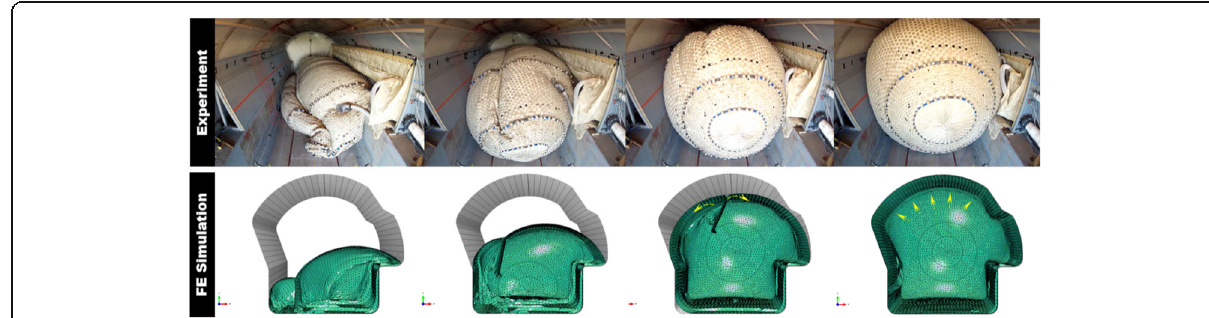
Fig. 16 Phase 2b-ET, full-scale testing, and three-layer Vectran plug. Initial inflation and holding of membrane material by passive restrainers (top). For additional details see [[69]92 – 94]. Cross-section of finite element simulation of initial inflation and sequence membrane release